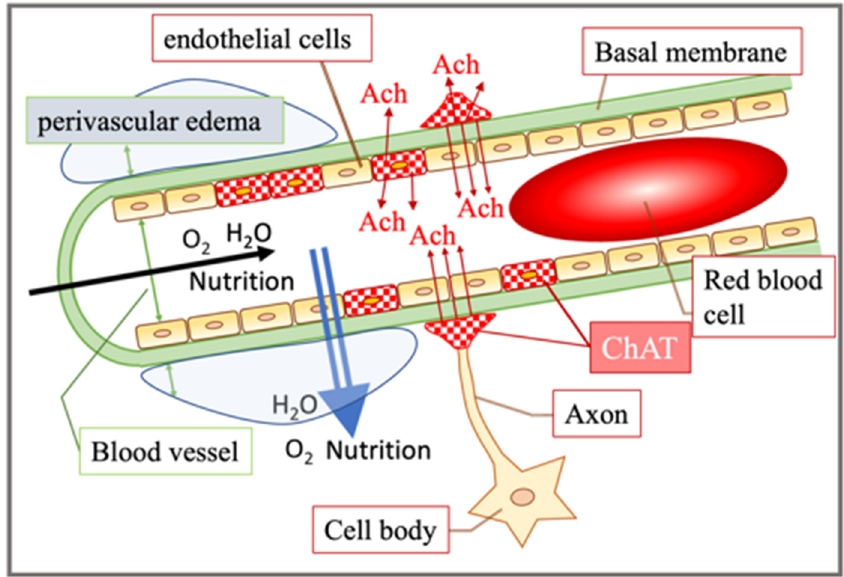
Figure 9. Schema of the changes in blood vessel after long-term smart drug administration is shown. Long-term smart drug administration induced ChAT expression in the vascular endothelial cells and induced perivascular edema. ChAT: choline acetyltransferase; Ach: acetylcholine. induced perivascular edema. ChAT: choline acetyltransferase; Ach: